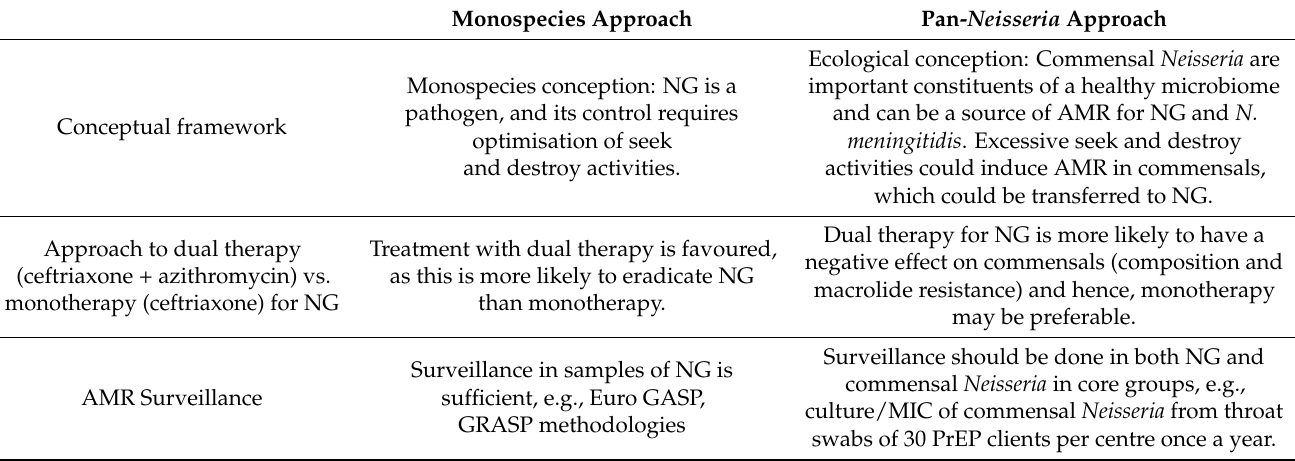
Table 1. Select differences between the monospecies and pan-Neisseria approaches to selecting new N. gonorrhoeae (NG) therapies. Monospecies Approach Pan- Neisseria